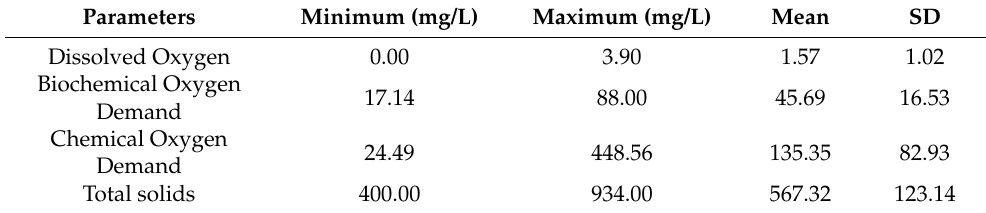
Table 1. Initial Characteristics of Wastewater .